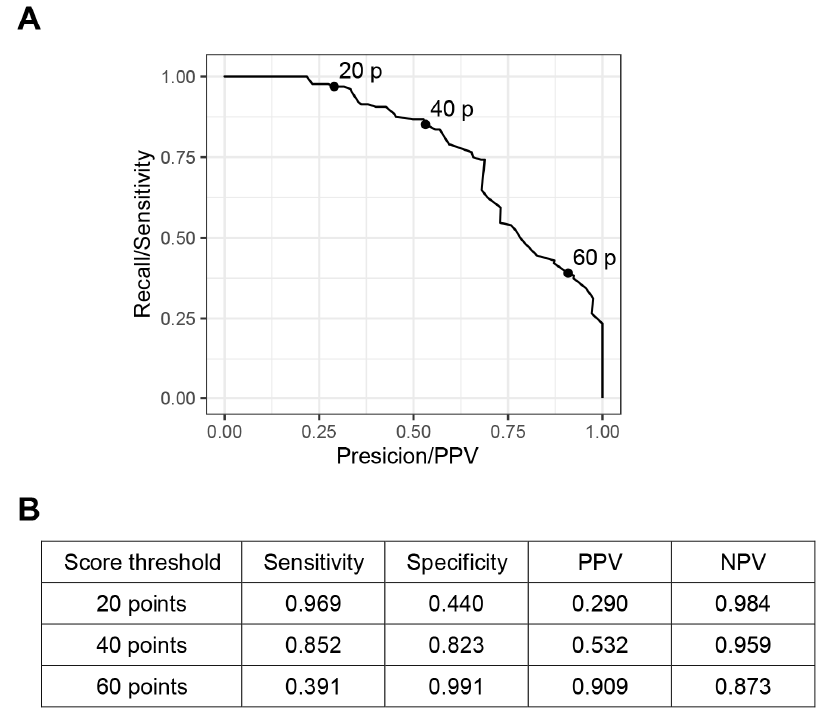
Figure 4. Prediction performance illustrated by a precision-recall curve with the score threshold. ( A ) The graph shows the precision-recall curve for the risk of the mechanical ventilation requirement. The precision (positive predictive value) and recall (sensitivity) values of the score threshold 20, 40, and 60 are presented as dots (20 p, 40 p, and 60 p). ( B ) The exact values of sensitivity and specificity, positive predictive value, and negative predictive value according to the score thresholds are pre- sented. PPV, positive predictive value; NPV negative predictive value. Table 4. Risk categories according to the risk scores.